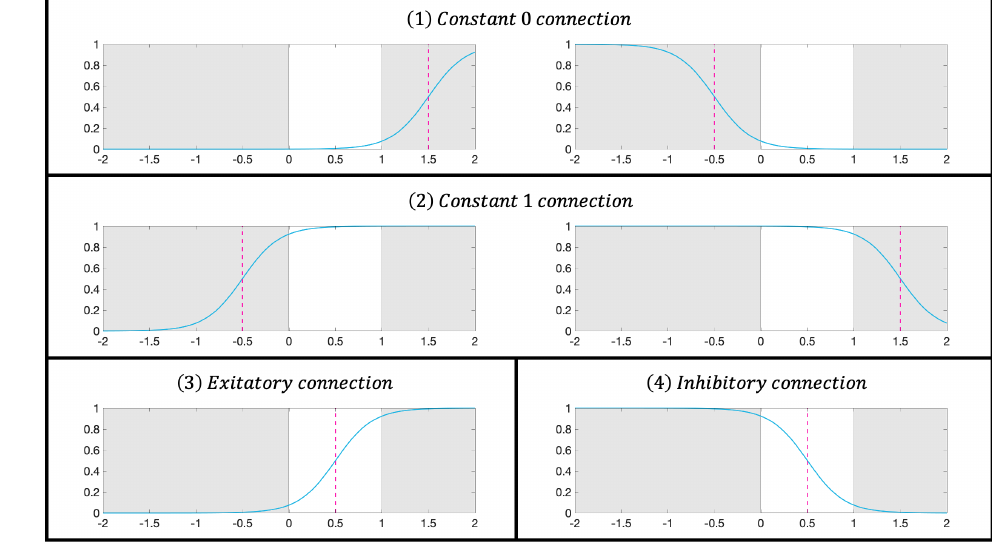
Figure 2. Four types of connection in the synaptic